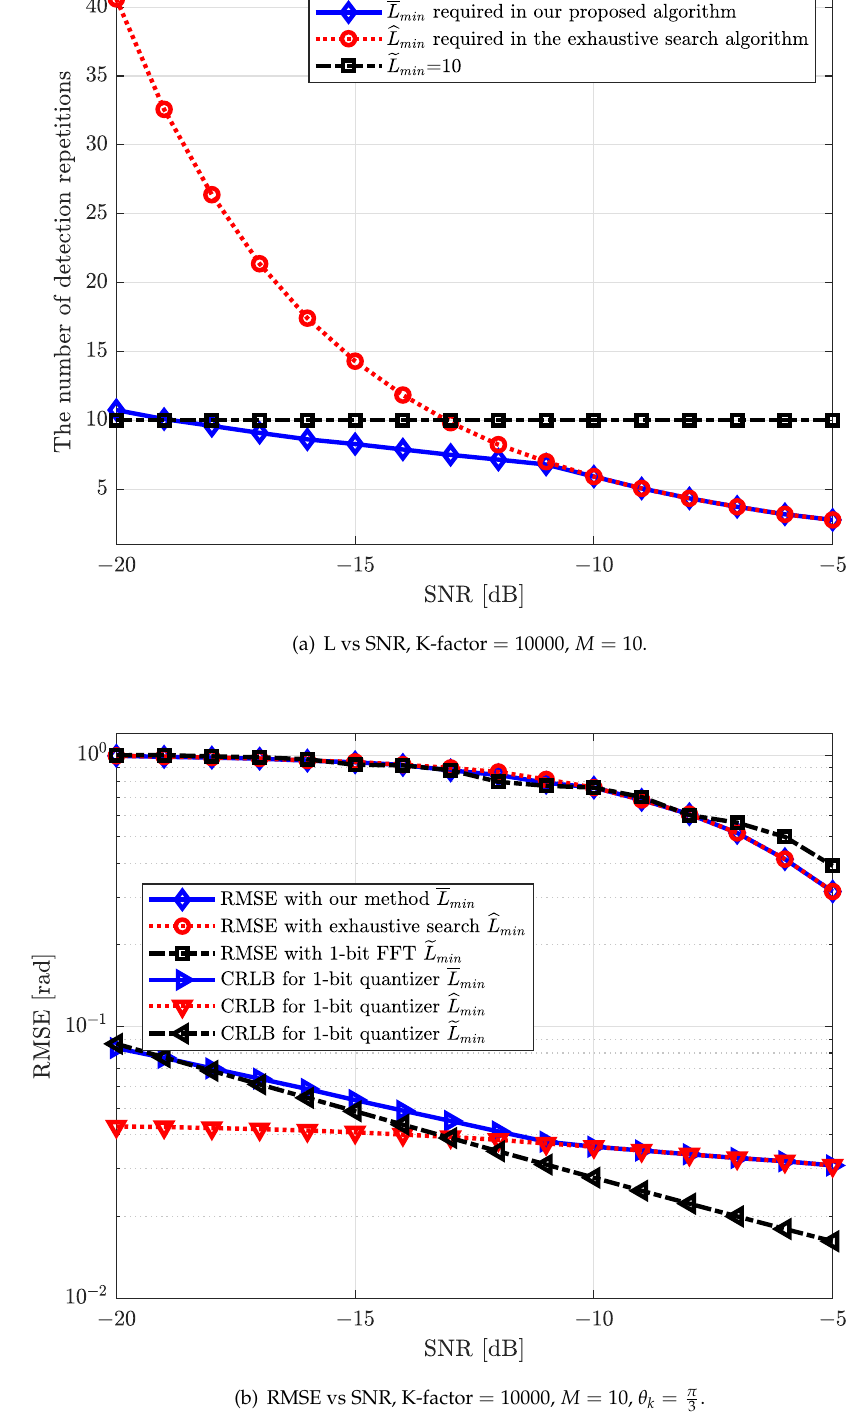
Figure 6. ( a ) The number of detection repetitions required for different algorithms versus different SNR for M = 10; ( b ) RMSE [rad] versus different SNRs for M = 10 with our proposed beamforming direction search algorithm, the exhaustive search algorithm and 1-bit